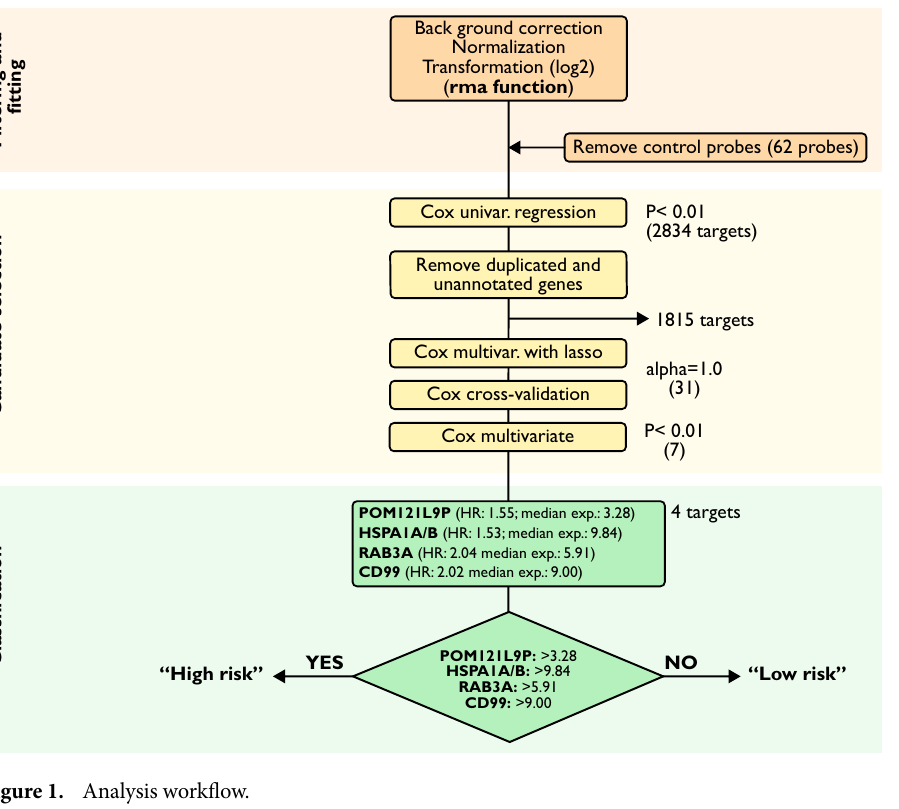
Figure 1. Analysis